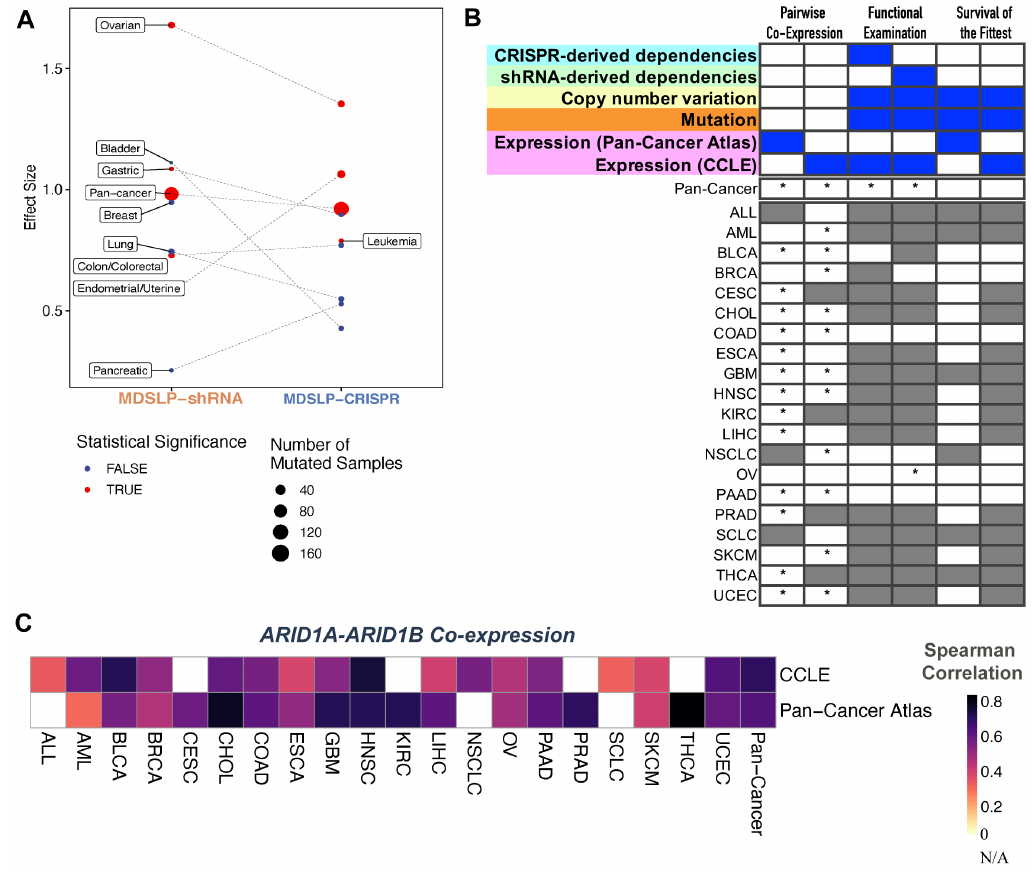
Figure 5. SL-Cloud enables cancer type-specific synthetic lethal inference for ARID1A and ARID1B. A . Evidence for synthetic lethality generated from the mutation-dependent synthetic lethality prediction (MDSLP) workflow as applied to cancer cell line dependency datasets when comparing the gene dependency scores (effects) for the shRNA and CRISPR datasets between the ARID1A-mutated group and wild- type group for different cancer types and across all cell lines (pan-cancer analysis). The threshold for statistical significance is FDR < 0.05. B . Statistical evidence for a synthetic lethal relationship between ARID1A and ARID1B from the DAta mIning SYnthetic lethality identification workflow (DAISY), with the results for each inference module being represented in the columns. Column heatmaps summarize the datasets used for each procedure. An asterisk (*) indicates that a test passed the FDR threshold (0.05); gray shading represents an invalid test or a lack of data availability. Gray shading represents an invalid test. C . Heatmap visualization depicting the Spearman correlation between ARID1A and ARID1B for the annotated cancer type for a patient derived sample (Pan-Cancer Atlas) or cancer cell line (CCLE) (rows) across different cancer types